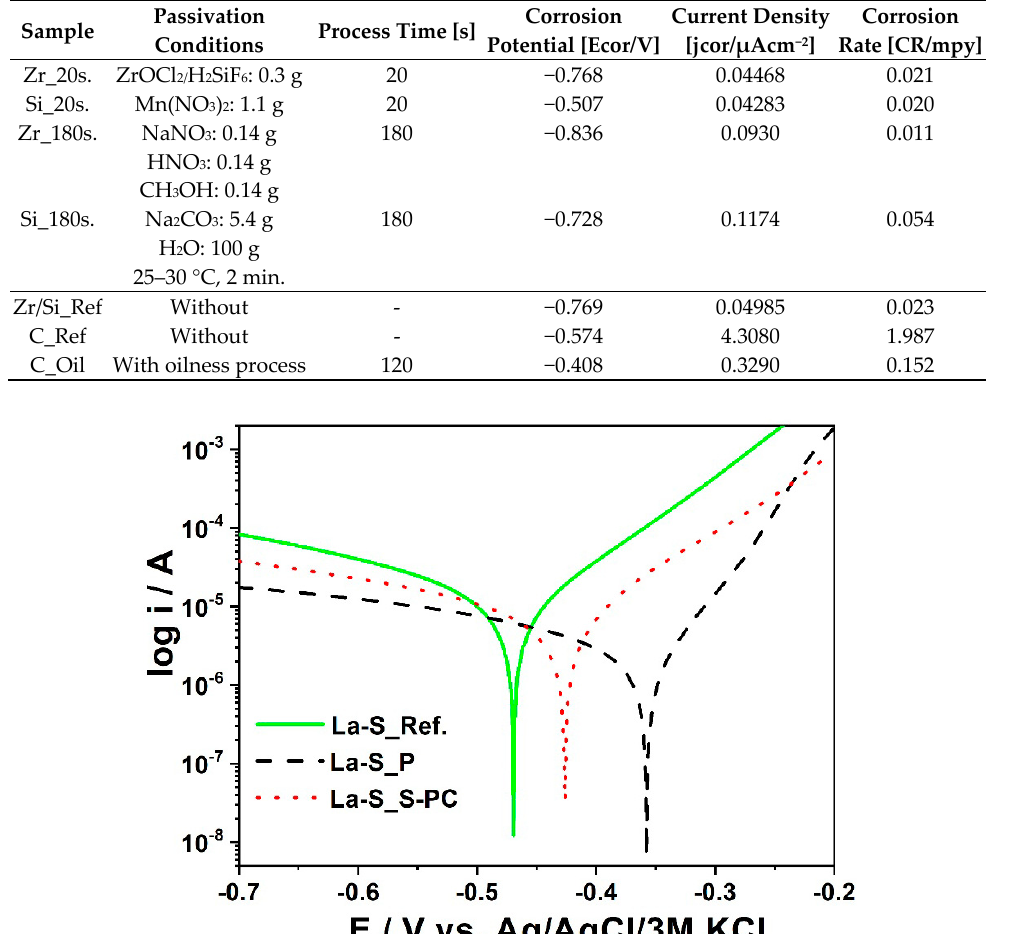
P_200s Figure 17. XRD patterns for the P_Ref, P_20s, and P_200s samples. Solid red lines are measured patterns, the green tickmarks correspond to Mn 2.5 (HPO 4 )(PO 4 )(H 2 O) 2 phase, and the blue tickmarks correspond to iron. Table 11. The values of corrosion potential, current density, and corrosion rate estimated for samples chemically treated in passivation conditions. Sample